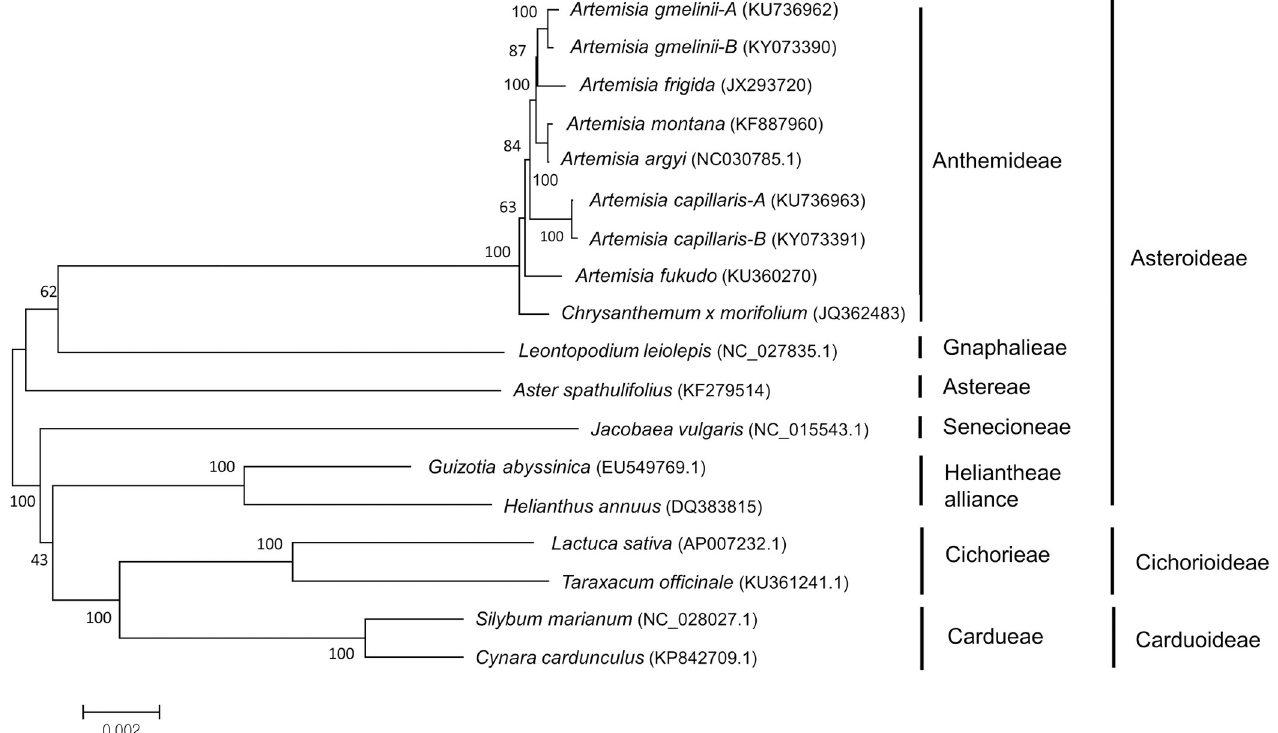
rpl32-trn (UAG) (Figs 4 and S1). Five markers, ar09, ar16, ar20, ar32, and ar42, were used to distinguish between A . gmelinii and A . capillaris . Two markers, ar44 and ar46, were specifically identified in A . fukudo . PCR analysis showed that the developed markers produced PCR amplicons of different sizes, regardless of intraspecific variation in A . capillaris and A . gmelinii , with successful discrimination among the three species (Fig 4). We then tested whether our barcode markers could be applied to real-world Artemisia products. Twenty dried herbs labeled A . gmelinii , A . capillaris , A . annua , and A . apiacea , were collected from the market and tested. Five markers, ar09, ar16, ar20, ar32, and ar42,